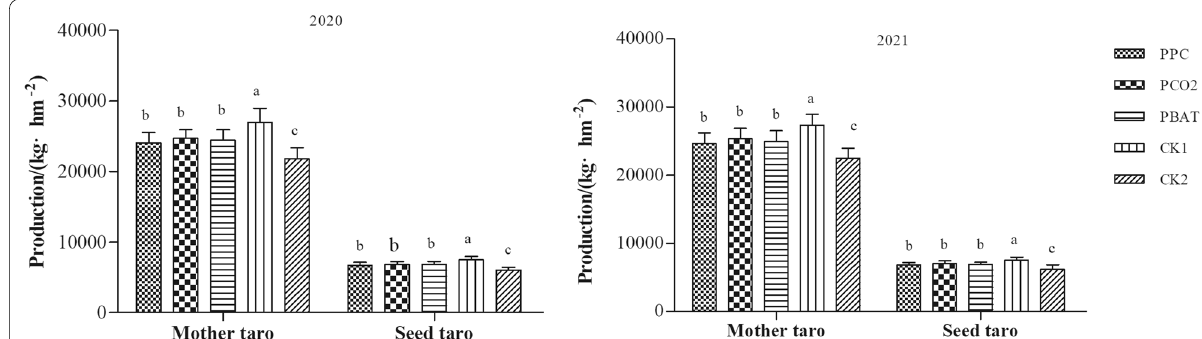
Fig. 5 The taro longxiang production of different biodegradable films. Different lowercase letters indicate significant difference between treatments (P < 0. 05)